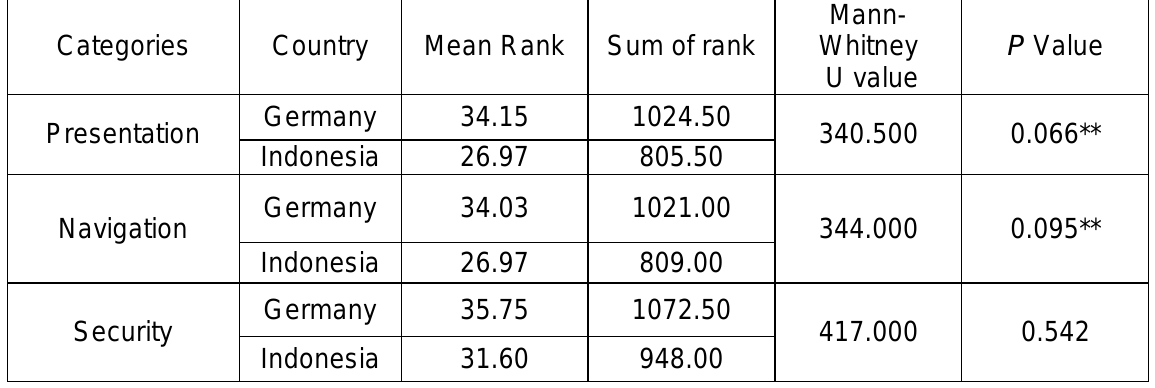
Table 4. Mann-Whitney U test of German and Indonesian hotel